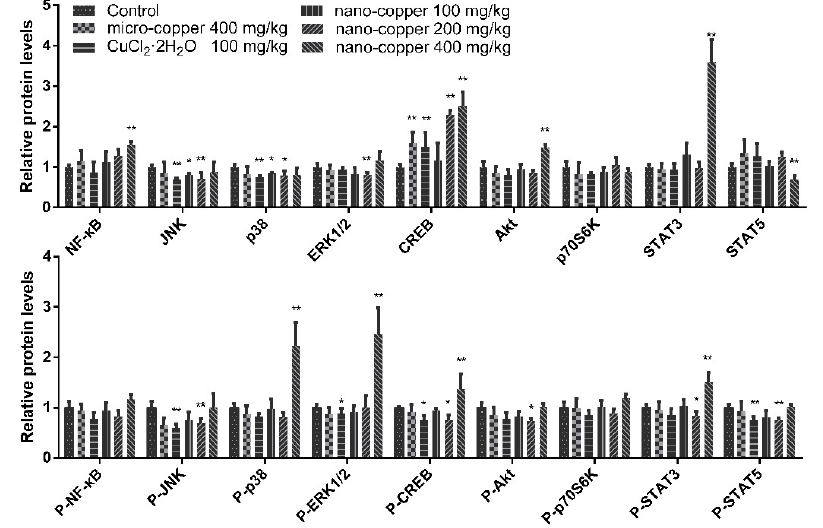
Figure 5. Changes in select signaling pathways in rat livers. * p < 0.05, ** p < 0.01 vs. control group. The P- showed the level of phosphorylated protein. The total signal proteins of NF- κ B, CREB, Akt and STAT3, and the phosphorylated signal proteins of p-38, p-ERK1/2, CREB and STAT3 were induced by nano-copper.